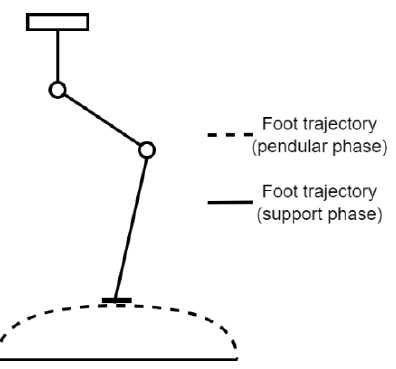
Figure 2. A simple trajectory for the robot foot.